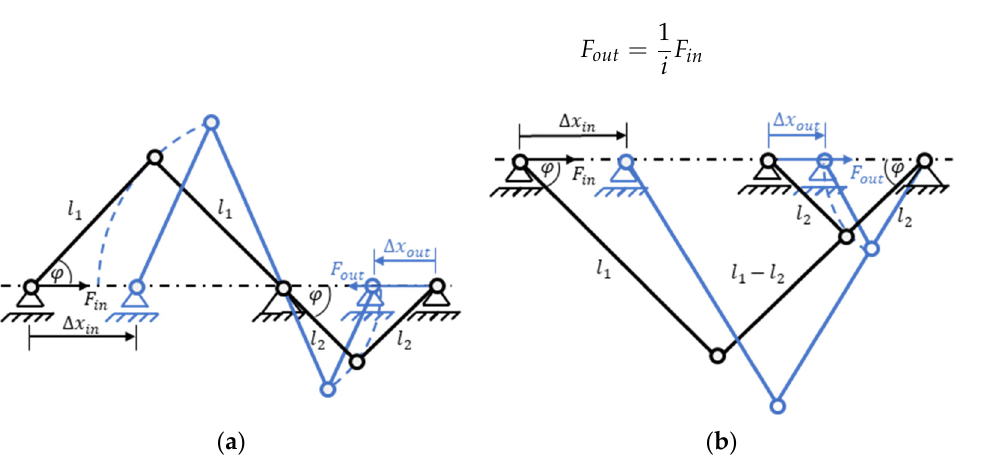
Figure 4. Kinematic chain of a scissor linkage with link lengths of l 1 and l 2 , rotation angle ϕ , input stroke ∆ x in , output stroke ∆ x out and corresponding forces F in and F out in ( a ) an inverting transmission configuration and in ( b ) a non-inverting configuration.